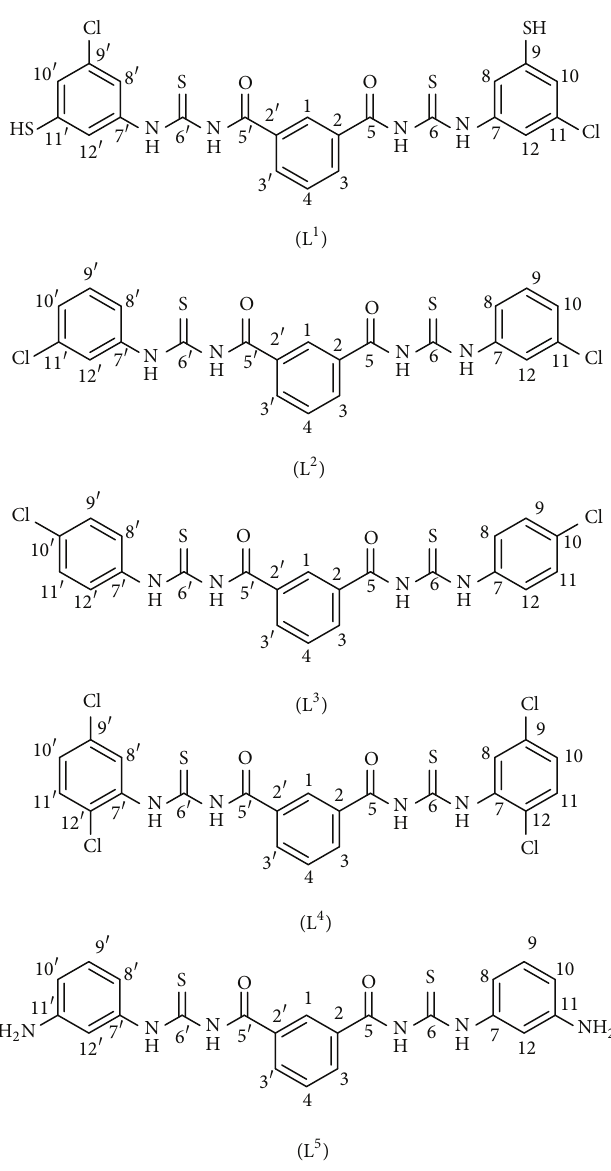
Figure 1: Bisthiourea derivatives (ligands L 1 –L 5 ).